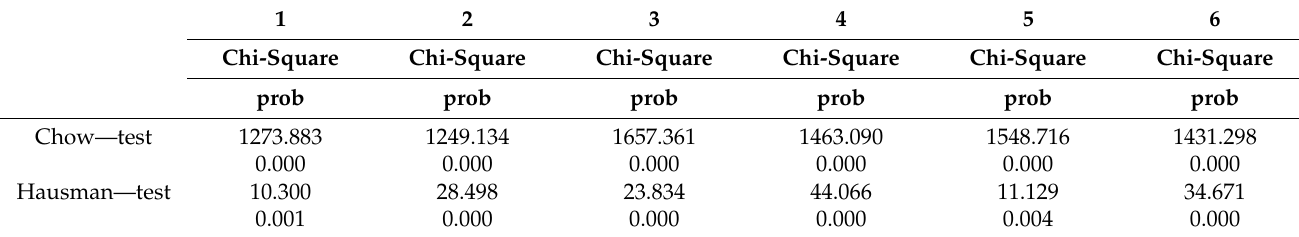
Table 5. Chow and Hausman Tests.